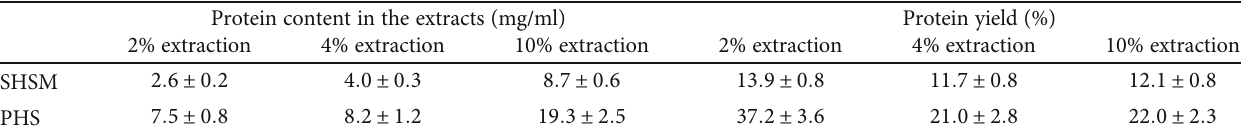
Table 2: Protein concentrations of the soluble fractions and corresponding protein yields obtained from the extractions using di ff erent solid